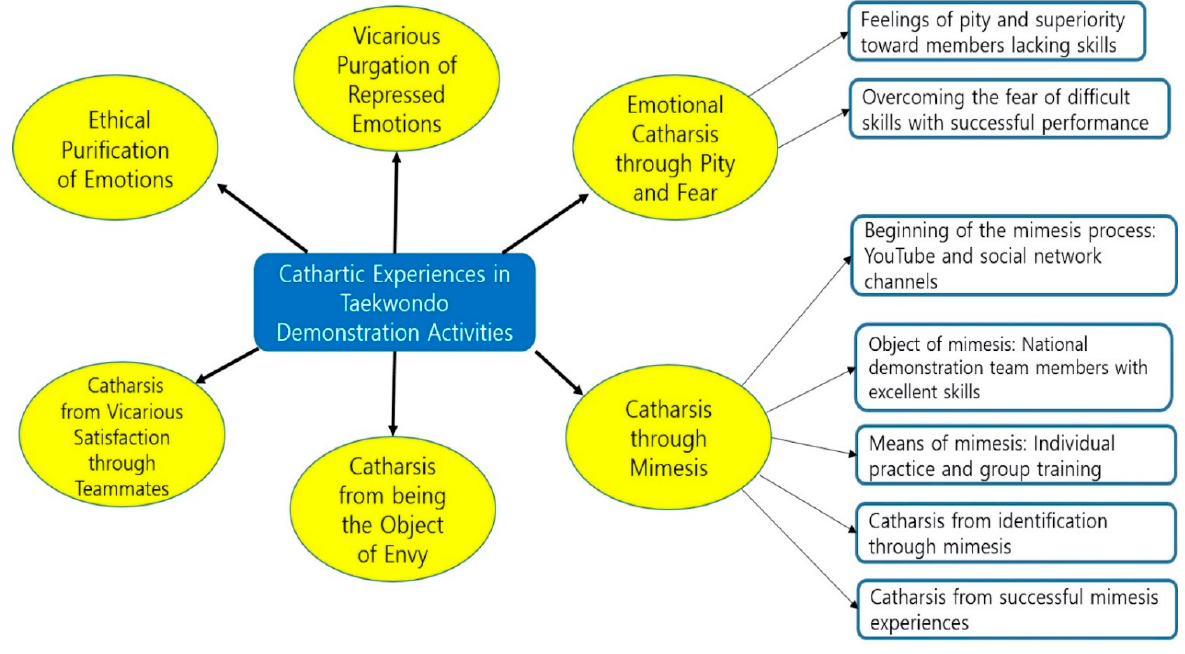
Figure 1. Result Figure 1. Result diagram.